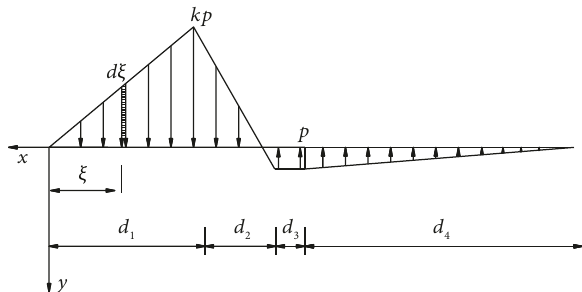
Figure 4: Computational mechanics model of overburden stress.